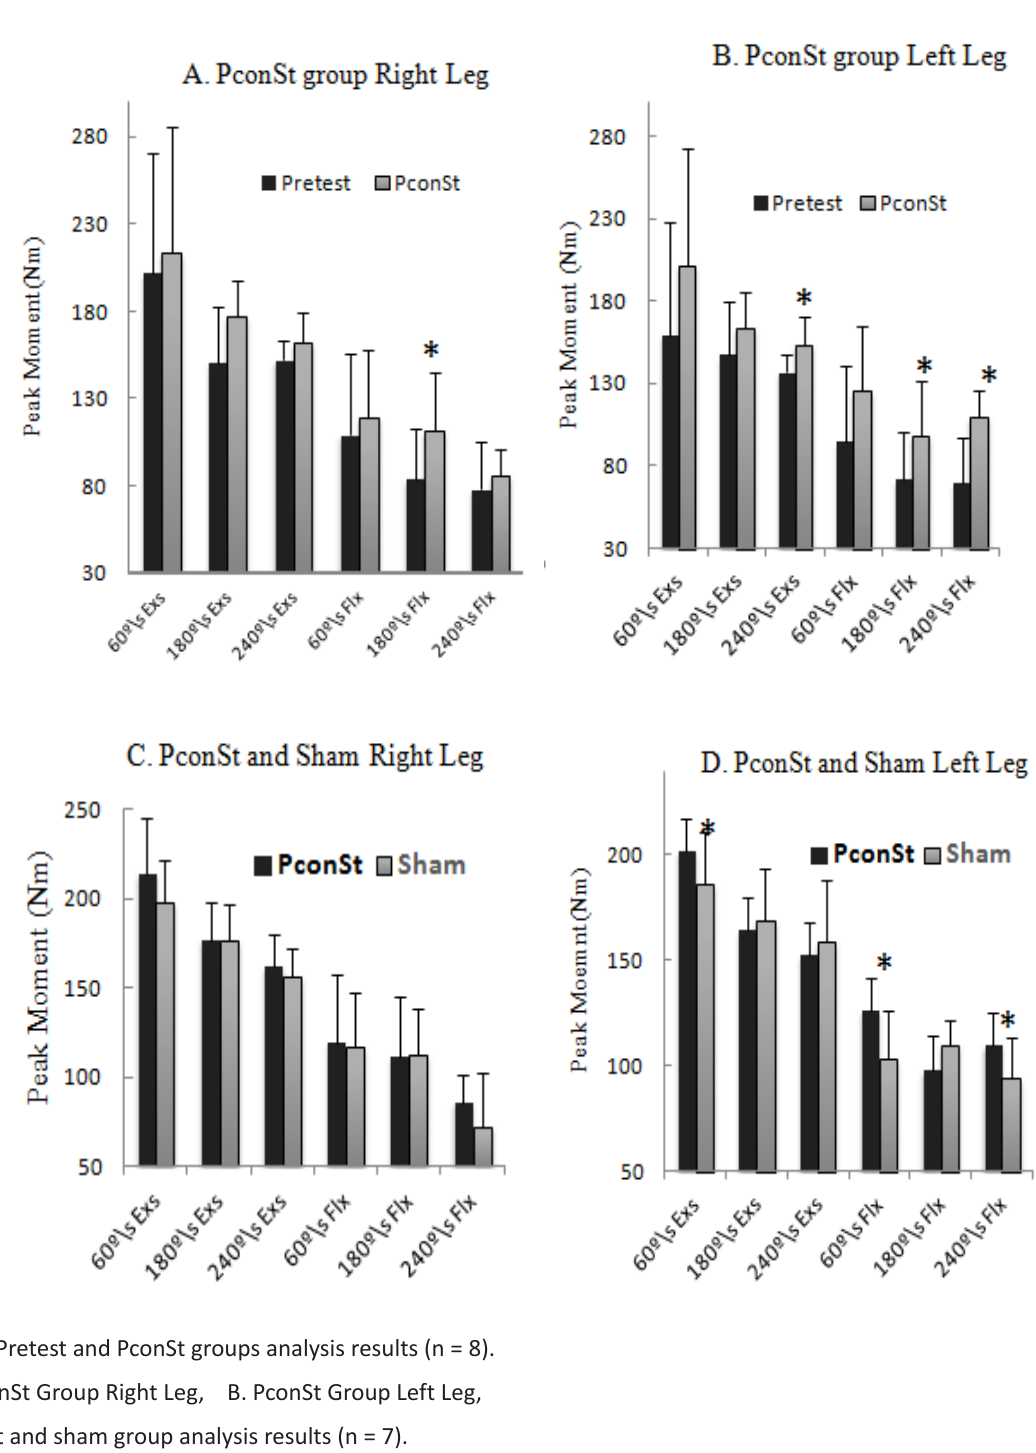
Fig 3. Pretest and PconSt groups analysis results (n = 8). A. PconSt Group Right Leg, B. PconSt Group Left Leg, PconSt and sham group analysis results (n = 7). C. PconSt and Sham Right Leg, D. PconSt and Sham Left Leg. Values are means ± SD (*p < 0.05). Exs = Extension, Flx = Flexion, 60, 180 and 240 represent angular velocity in degrees per second